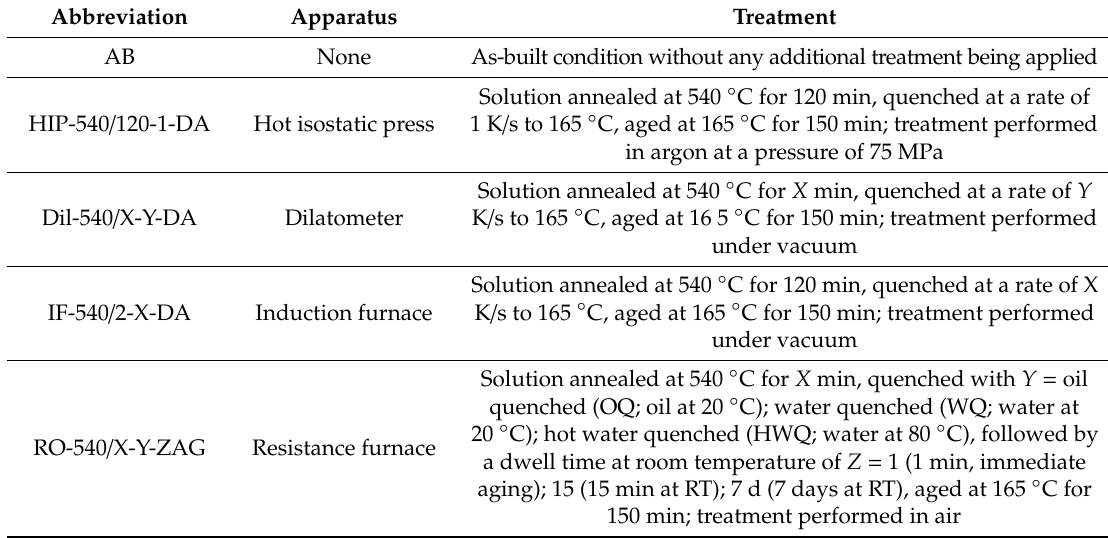
Table 2. Detailed explanation of applied heat treatments and nomenclature.